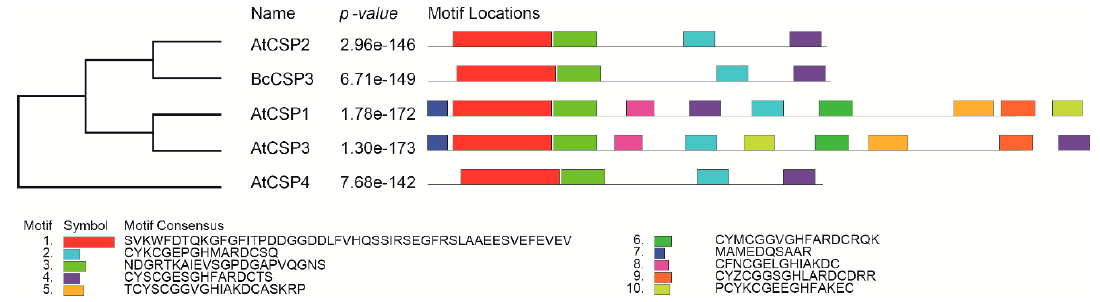
Figure 5. Phylogenetic and motif analysis of the putative BcCSP3 protein and Arabidopsis CSPs. The unrooted tree is based on an alignment of the full-length protein sequences and was constructed by the neighbor joining